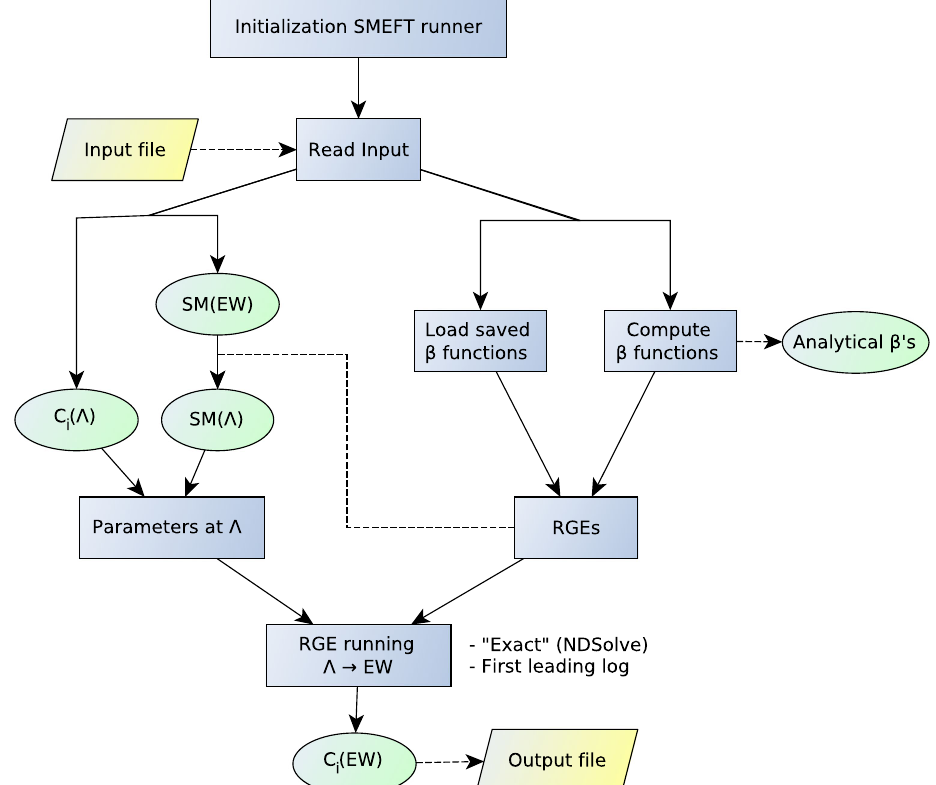
Fig. 3 SMEFTrunner module